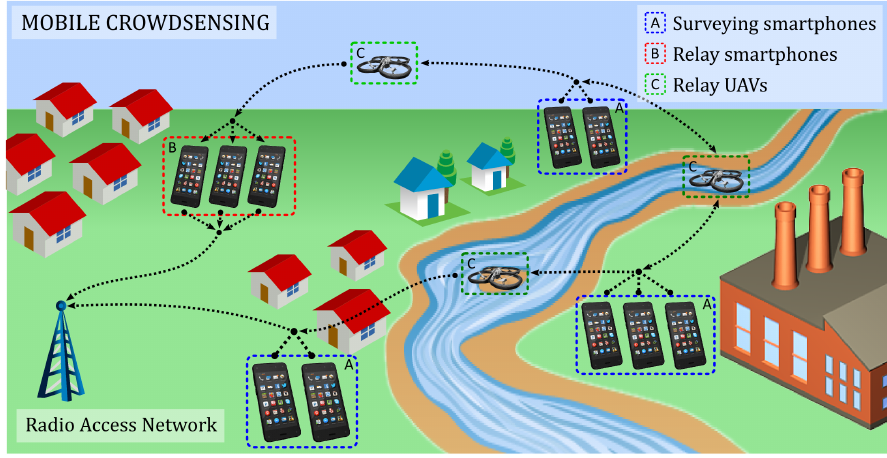
Figure 3. Mobile